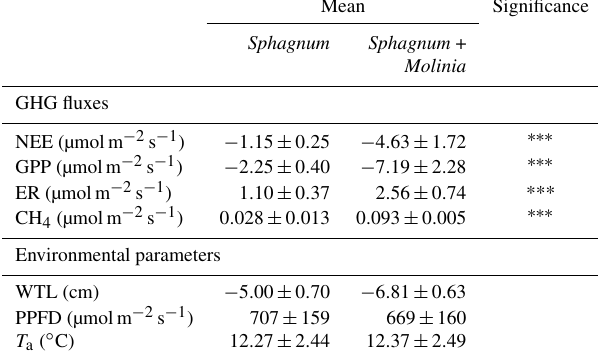
Table 1. Mean values of measurements of net ecosystem ex- change (NEE), gross primary production (GPP), ecosystem respira- tion (ER), CH 4 emissions (CH 4 ), photosynthetic photon flux den- sity (PPFD), water table level (WTL) and air temperature ( T a ) in Sphagnum + Molinia and Sphagnum plots. Significant differences of two-way repeated-measure ANOVAs are expressed as ∗∗∗ , with p< 0 . 001 ( n = 6). Data are presented as mean ± SE, where n =